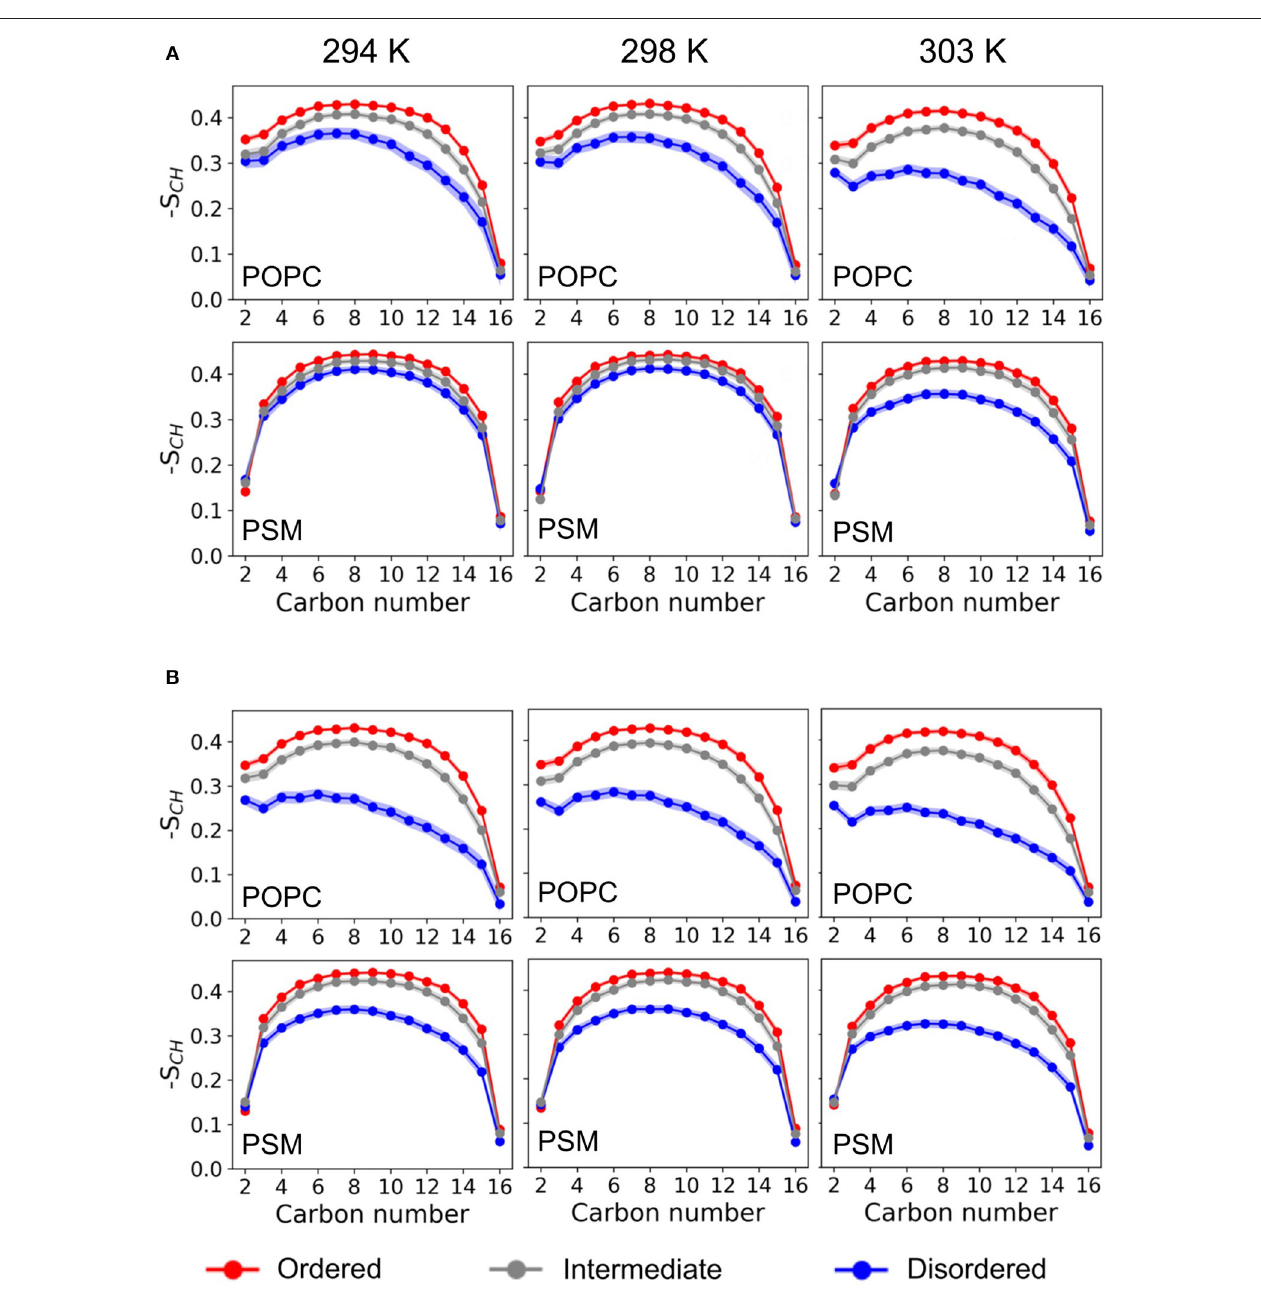
FIGURE 3 | Deuterium order parameter profiles. Shown are the deuterium order parameter profiles for the palmitoyl-chains of POPC (it sn-1) and PSM in the L O / D system at different temperatures for the different HMM-assigned membrane phases (ordered, disordered, intermediate) and without (A) or with (B) serotonin.